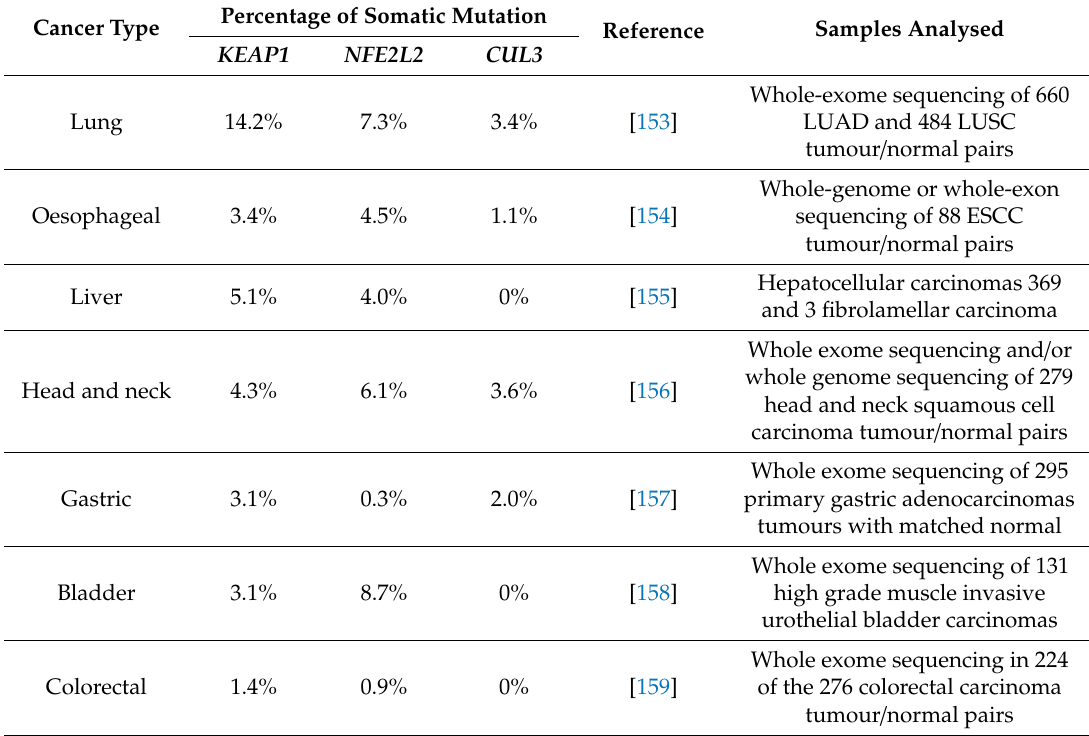
Table 2. Frequency of mutations in KEAP1 , NFE2L2 and CUL3 across di ff erent cancer